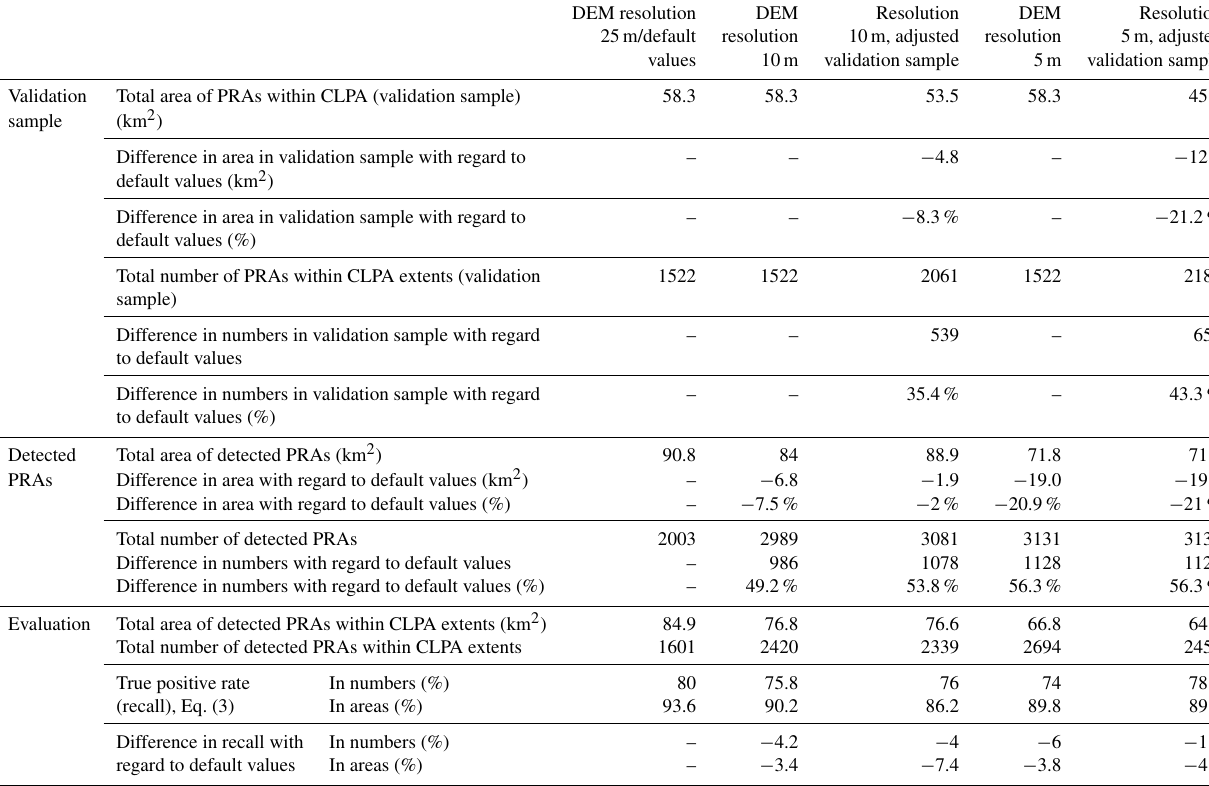
Table 7. Effect of DEM resolution on PRA detection, Mont Blanc massif. With both the 10 and the 5m resolution DEMs, two cases are considered: either the default validation sample determined with the 25m resolution DEM is kept, or a new validation sample is determined following Fig. 4. For both the PRA detection and the determination of the validation sample, all other factors are set to their default values (Figs. 3–4) and forest cover data are from DB forest